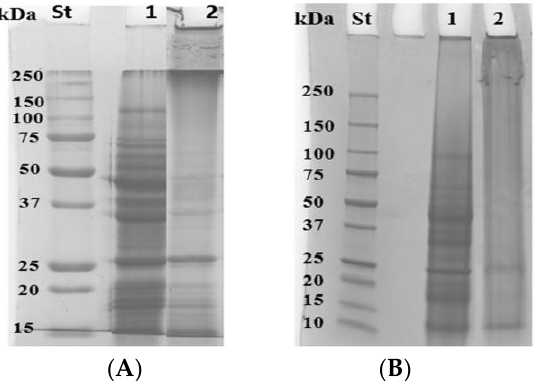
Figure 2. Panel A-SDS-PAGE of untreated (lane 1) and mTGase-treated (lane 2) FFSs. Panel B-SDS-